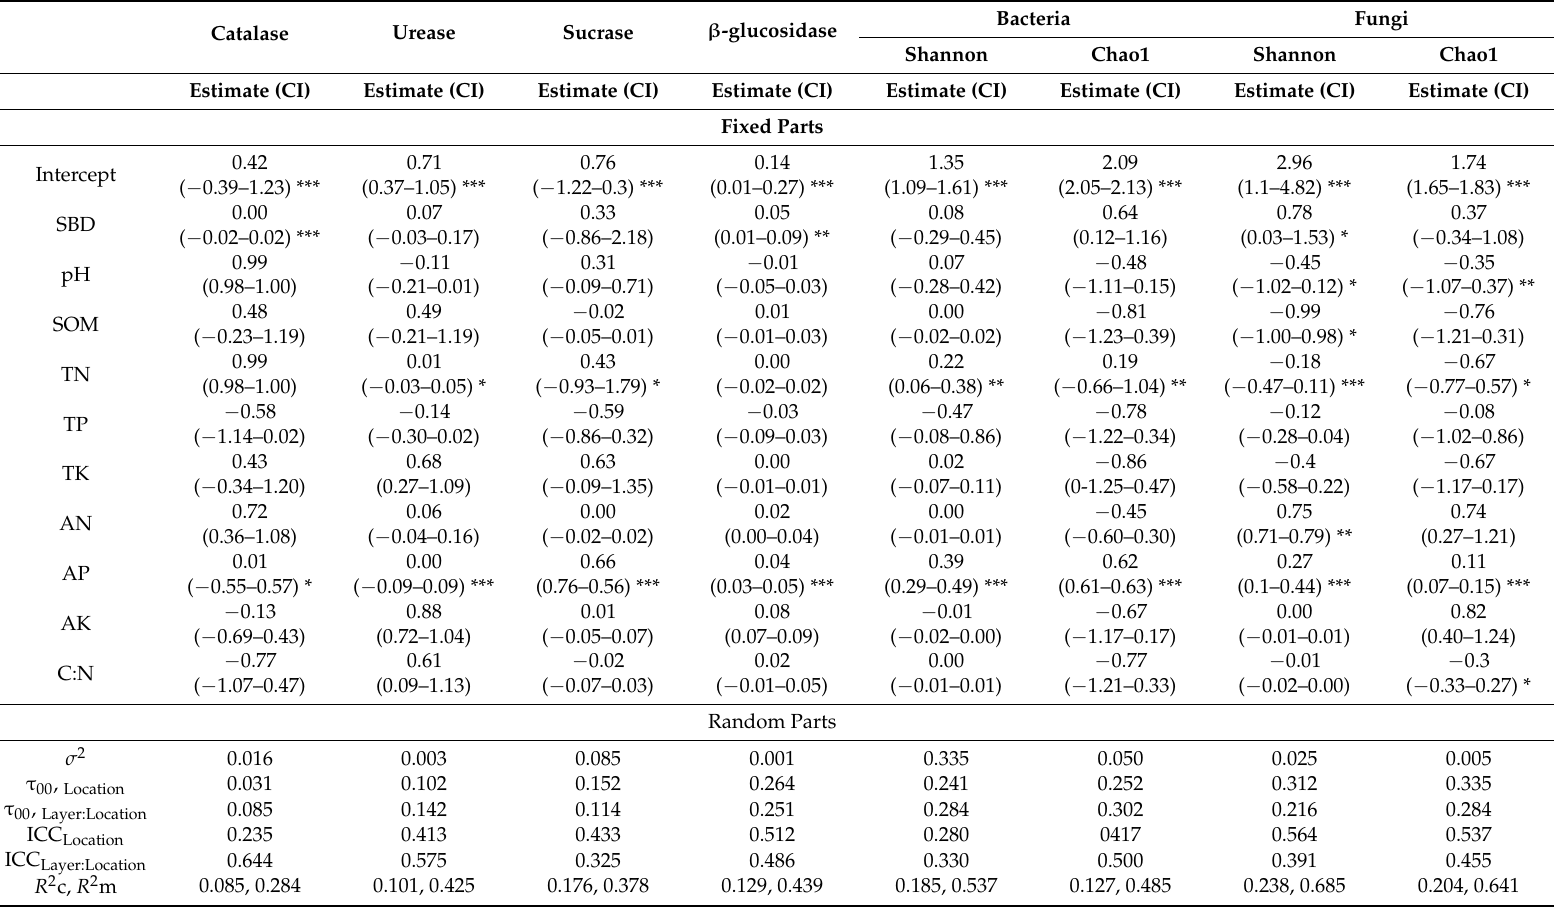
Table 4. Results from the linear mixed model (LMM) analysis of enzyme activities and microbial diversities. Response variables are reported in columns, while predictors (both fixed and random parts) are reported in rows. Location as random factor, layer as nested factor within location. Statistical significance is reported